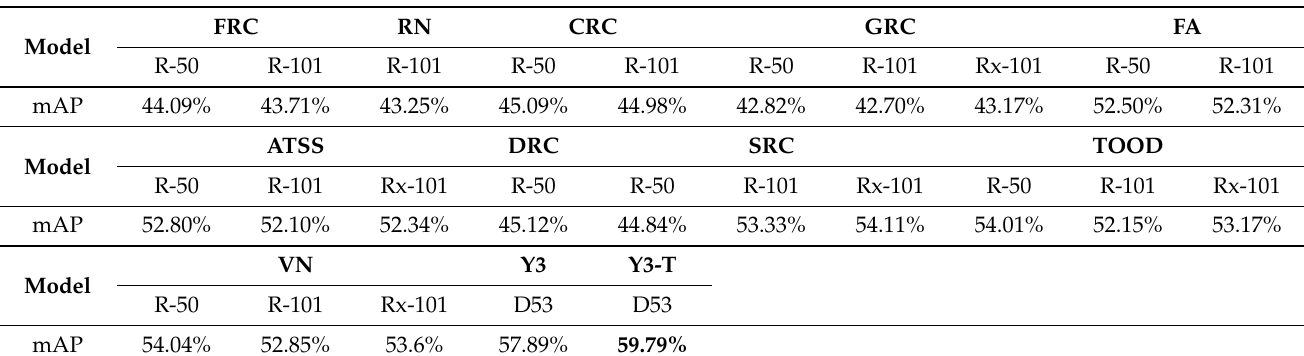
Table 6. Experimental results of IGBT_DF_L